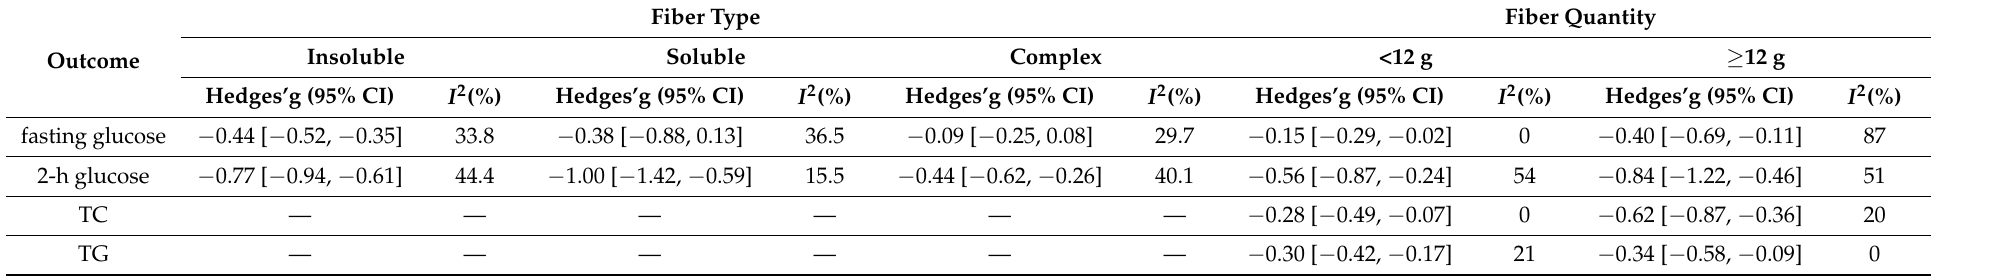
Table 3. The results of subgroup